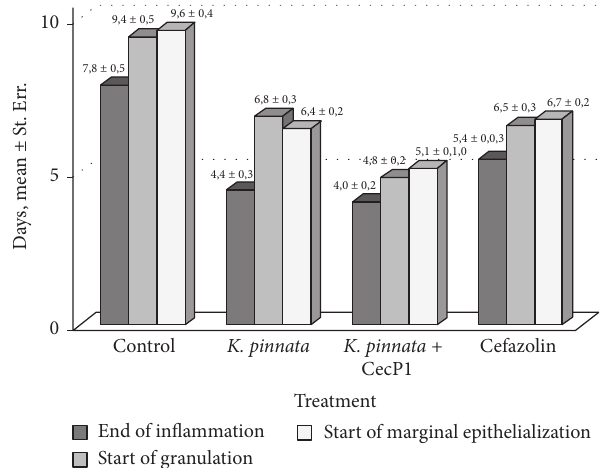
Figure 7: Testing microbicide activity of K. pinnata extracts against S. aureus mono infection in vivo.